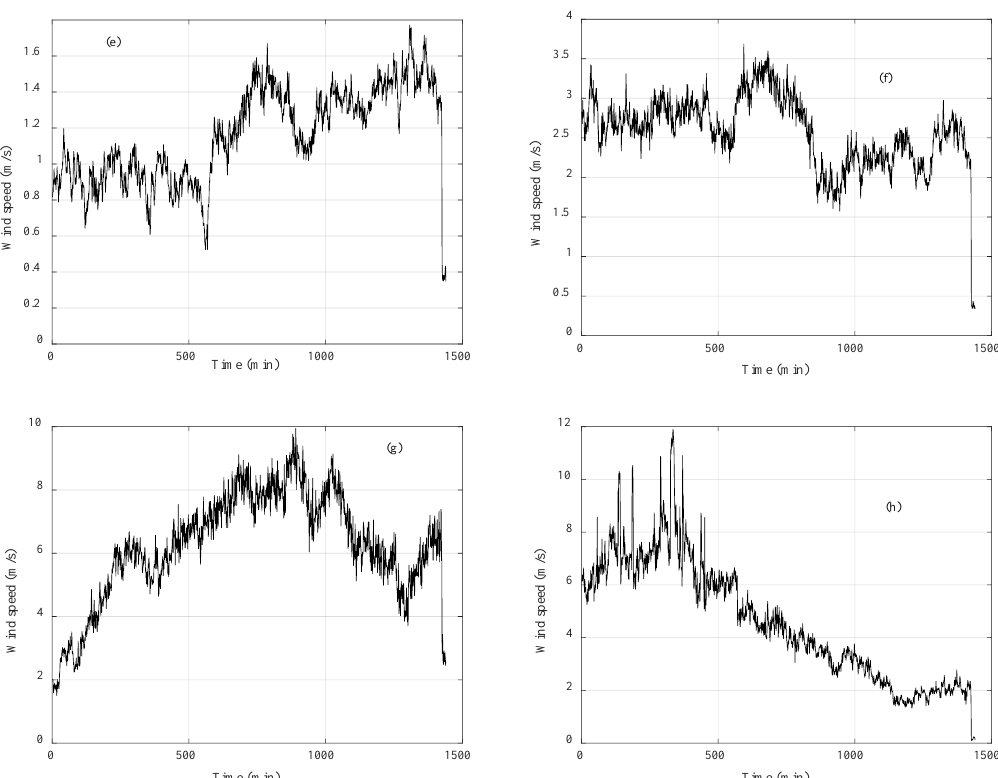
Figure 10. Wind speed profiles after the application of the K-means algorithm: ( a ) Profile#1; ( b ) Profile#2; ( c ) Profile#3; ( d ) Profile#4; ( e ) Profile#5; ( f ) Profile#6; ( g ) Profile#7; ( h ) Profile#8.